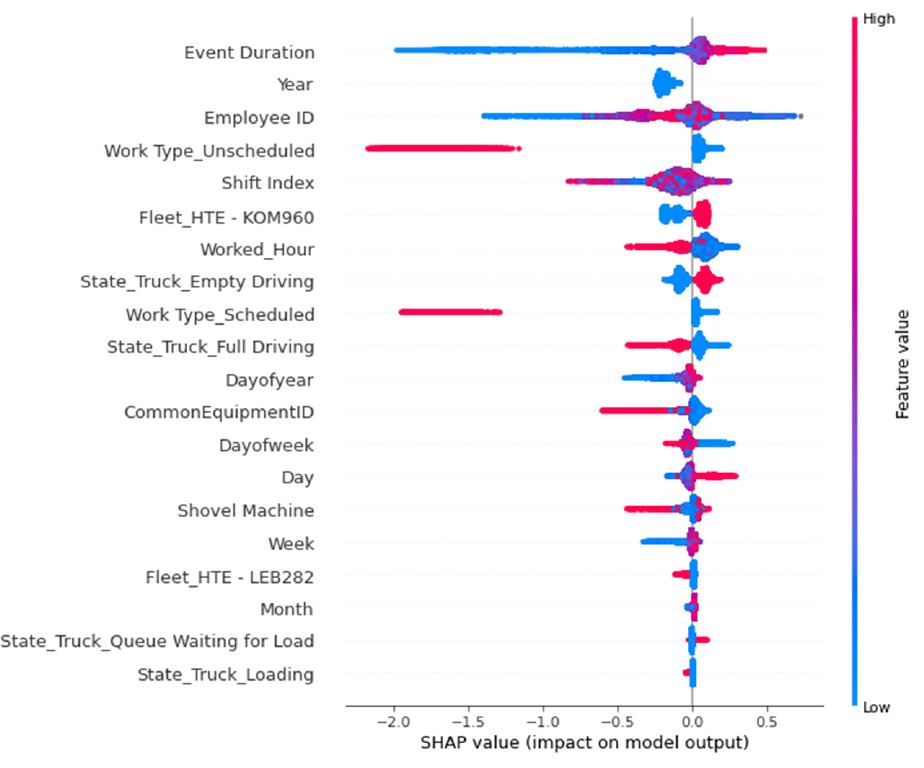
Figure 12. SHAP value of the third model.